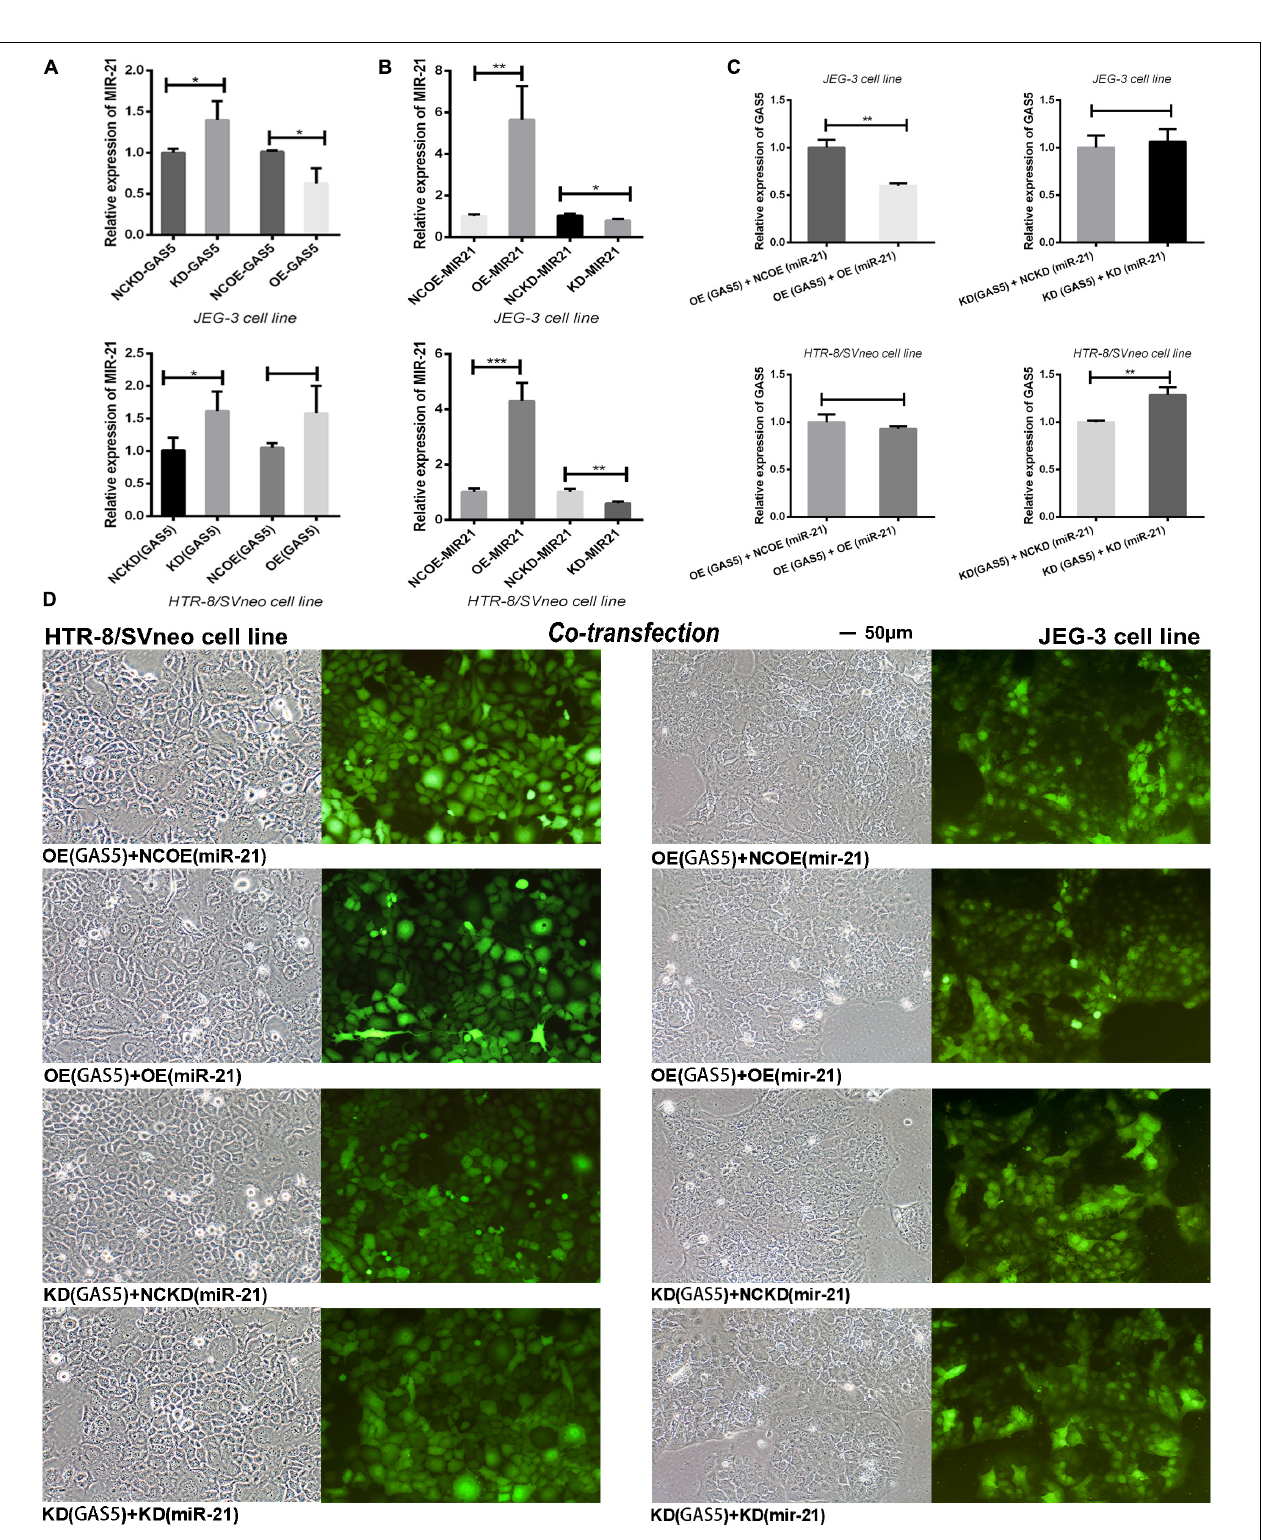
FIGURE 5 | (A) After altered the expression of GAS5, the levels of miR-21 demonstrated the reverse tendency. (B) The effective transfection rate of miR-21 lentiviral vectors was shown. (C) The “rescue” experiment of co-transfection of GAS5 and miR-21 reversed the expression levels of GAS5 in two cell lines. (D) The co-transfection efficiency was observed by the green fluorescent in trophoblasts and was adequate for the subsequent experiment. * P < 0.05, ** P < 0.01, *** P < 0.001.